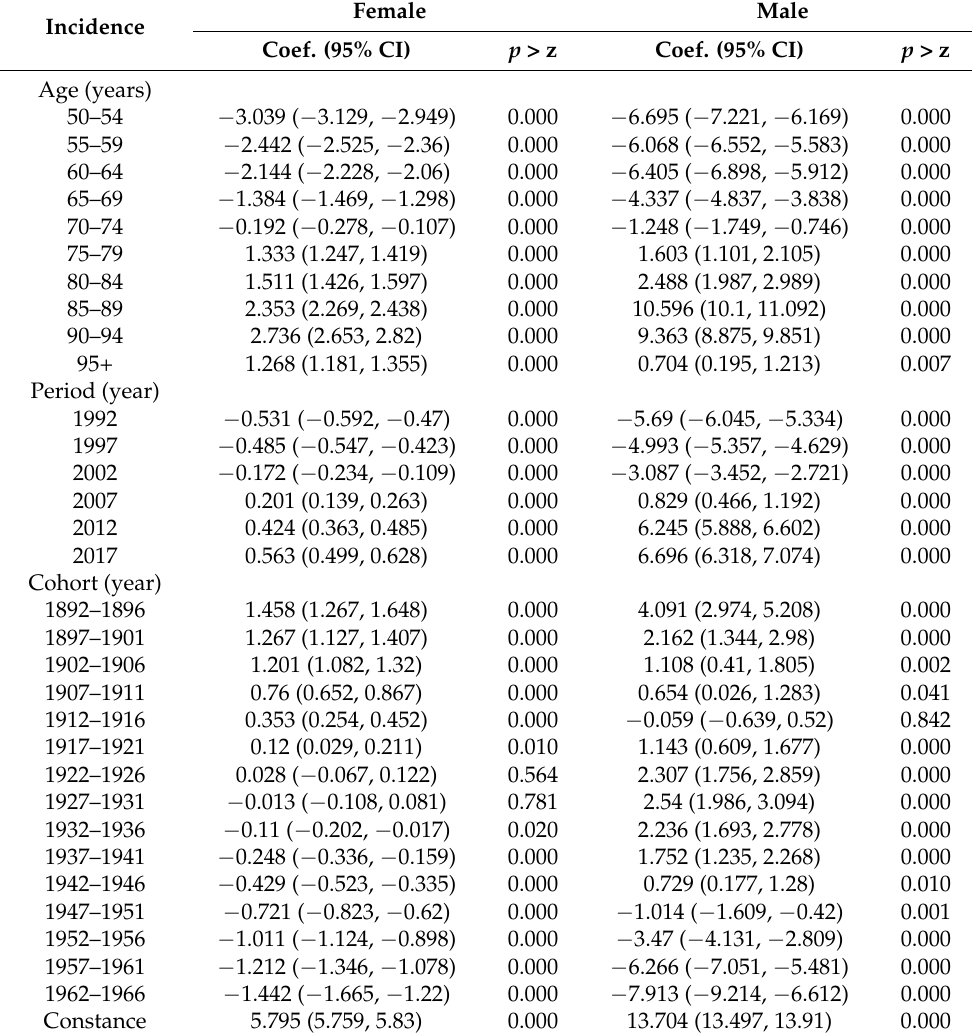
Table 2. APC model analysis of lip and oral cavity cancer incidence among females and males in China.